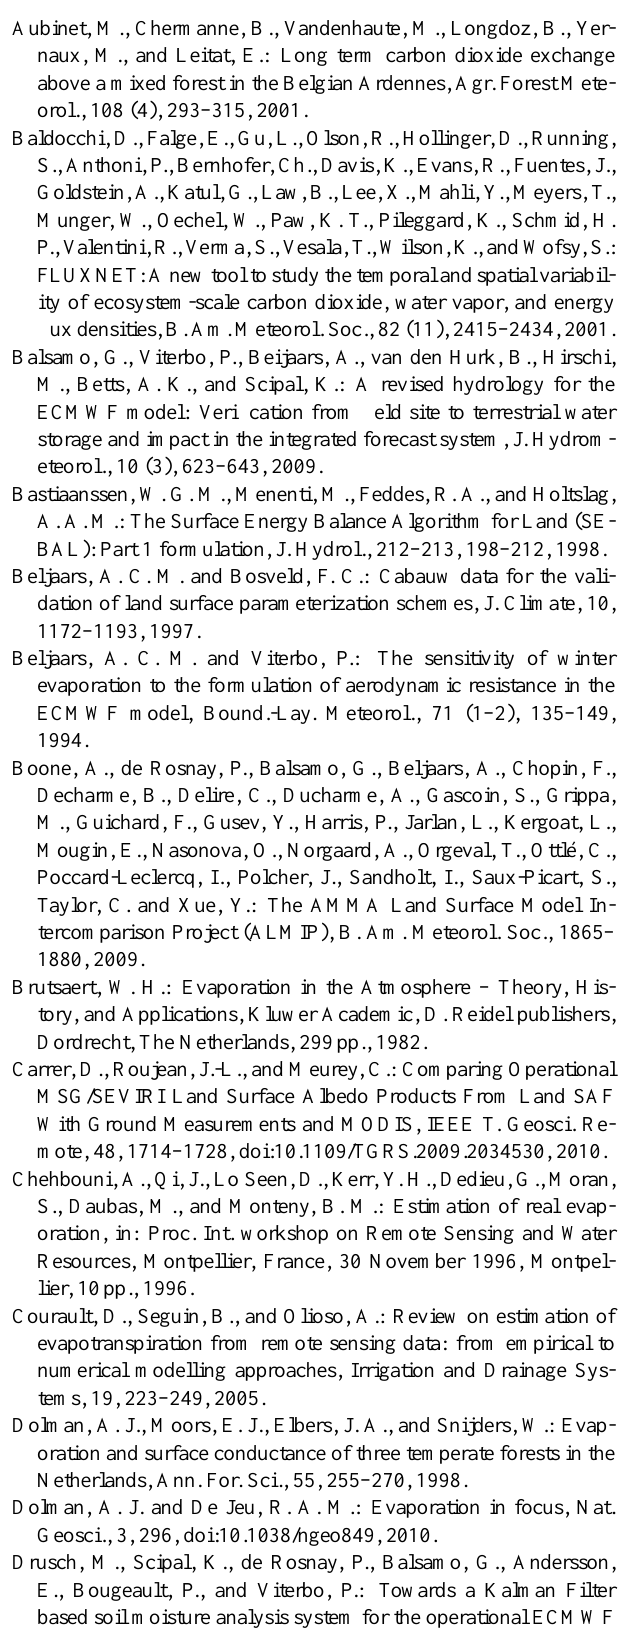
Table A2. Comparison between half-hourly ET measurements and ET estimates obtained by MET forced with local observations.